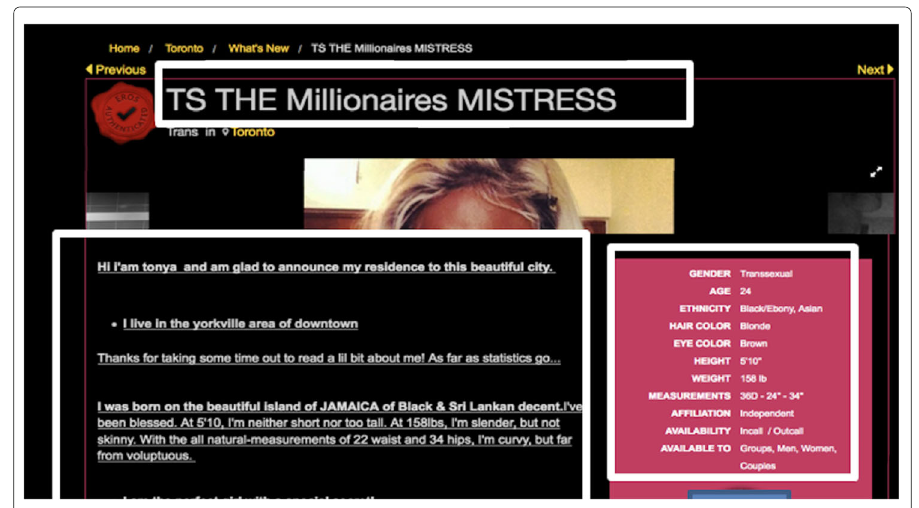
Fig. 1 A truncated example of a webpage (images/key information are obfuscated) from the online sex advertisement domain. White boxes indicate regions of the webpage containing critical attributes (e.g.,